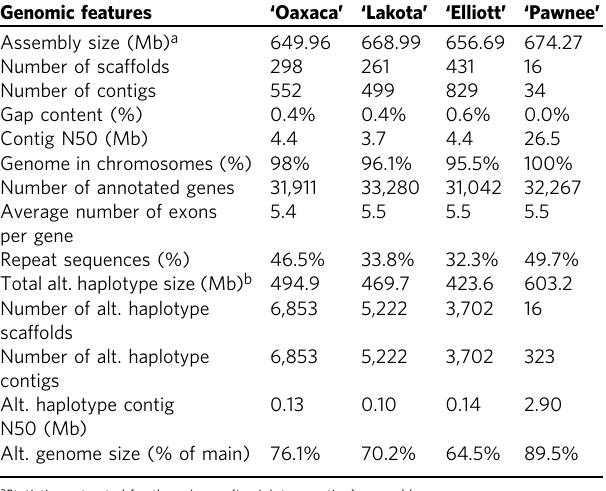
Table 1 Genome assembly and annotation statistics for each of the four